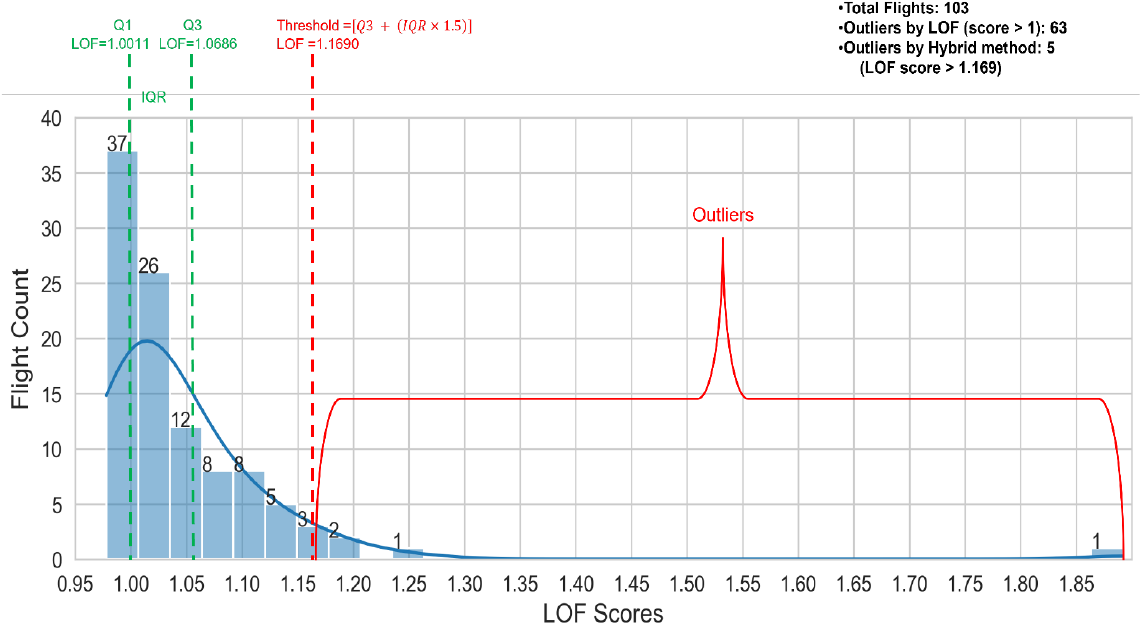
Figure 8. Fixing LOF threshold using Tukey’s method.